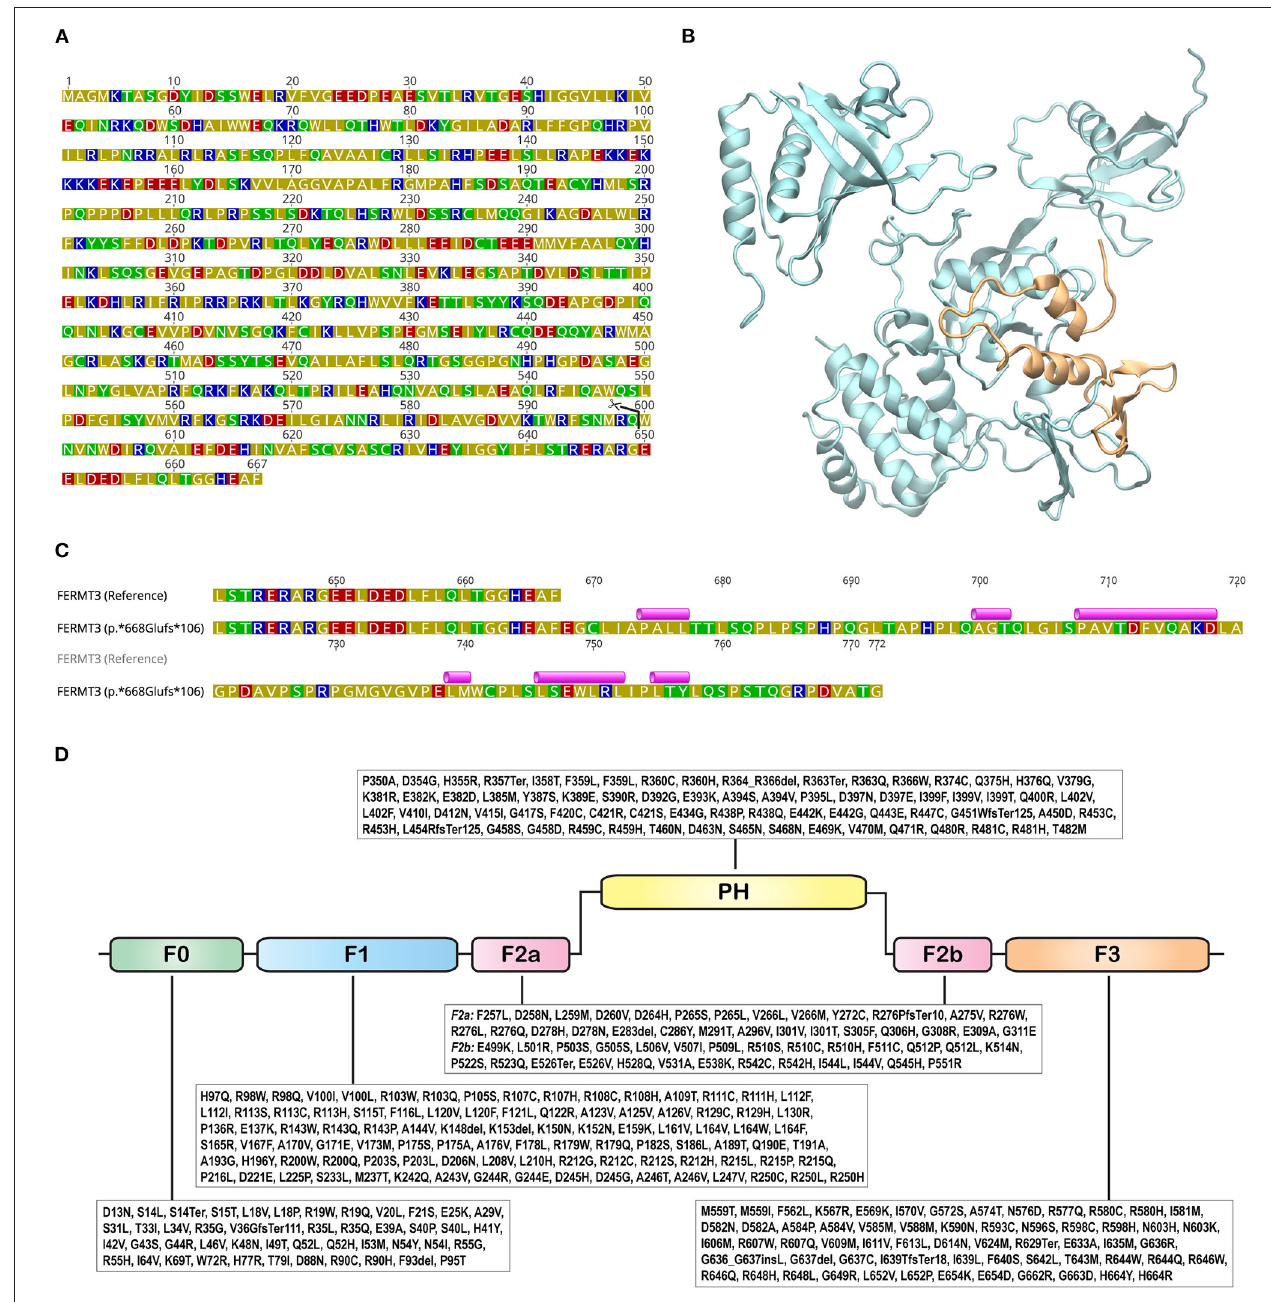
FIGURE 4 | Structure and sequence of FERMT3. (A) Sequence of FERMT3 (NCBI Accession: NP_848537.1) with the site of truncation in p.Trp600* shown with a pair of scissors. Amino acids are colored based on their polarity: blue - basic; red - acidic; green - polar; olive – hydrophobic. (B) Three dimensional protein structure of FERMT3, generated using the Protein Data Bank structure 7C3M, depicted in cartoon representation. The region truncated in the p.Trp600* non-sense variant is shown in orange. (C) Protein sequence alignment of FERMT3 (NCBI Accession: NP_848537.1) and the p.*668Glufs*106 non-stop variant starting from position 640. Secondary structures, predicted using PSIPRED 4.0 (Predict Secondary Structure; http://bioinf.cs.ucl.ac.uk/psipred/), in the extended region of the variant are shown above the sequence. Violet cylinders represent α -helices. (D) Variations identified in the canonical Ensembl transcript (ENST00000279227.5) were from gnomAD v2.1.1 are shown with amino acids represented by their one letter codes. FERM domains (sub-domains F0, F1, F2a, F2b, and F3; InterPro classifies region 258-558 as FERM central domain) and pleckstrin homology (PH) are shown as rounded rectangles. to the wild-type sequence. Basic Local Alignment Search Tool psipred/) (23) indicated that this region could potentially harbor (BLAST; https://blast.ncbi.nlm.nih.gov) (22) searches did not identify any homologous sequences or structures. Secondary six α -helices ( Figure 4C ). While secondary structures